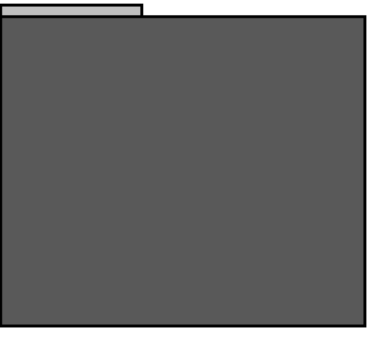
Figure 1. Section of substrate (dark grey) and splat (light grey).